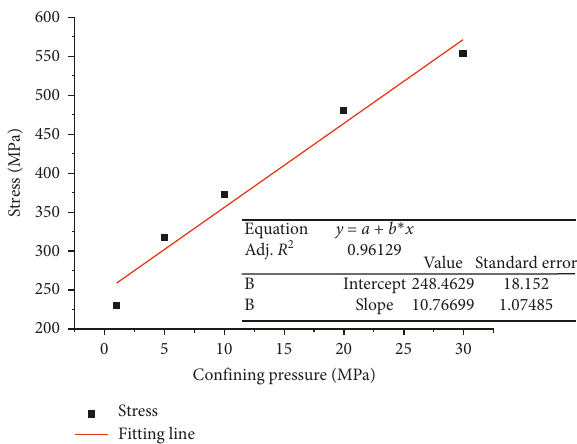
Figure 4: Confining pressure and peak stress of rocks fitting curve.